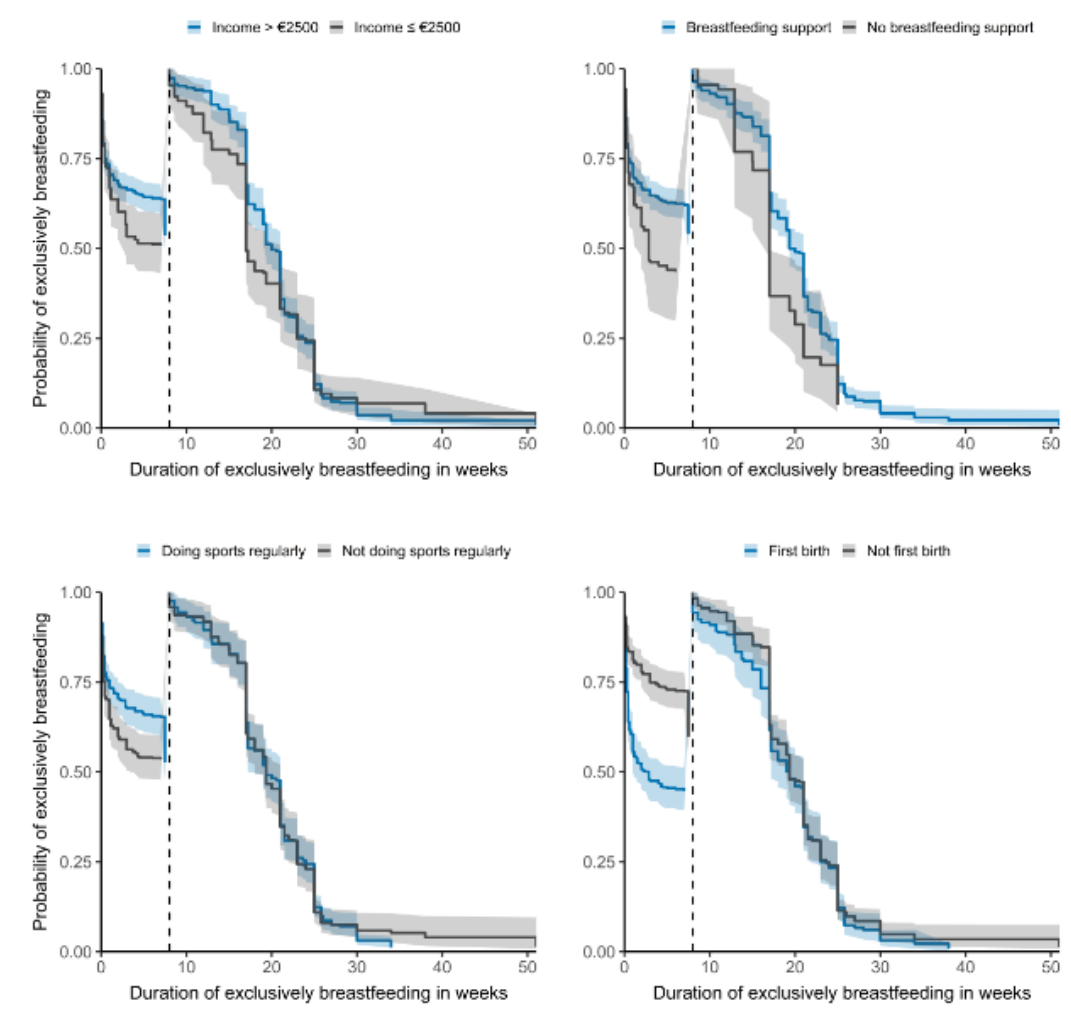
Figure 2. Kaplan – Meier survival curves for influencing factors on exclusively breastfeeding dura- Figure 2. Kaplan–Meier survival curves for influencing factors on exclusively breastfeeding duration tion ( n = 728). ( n =